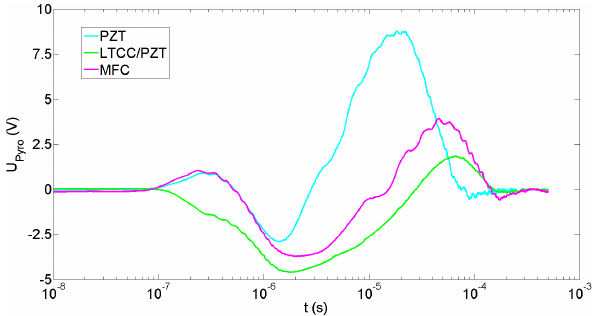
Figure 7. Time dependence of the output voltage of the current amplifier (10 8 VA − 1 , 7kHz bandwidth) for the PZT plate, the LTCC/PZT sensor–actuator and the MFC actuator for an optical power of 65W and a pulse width of